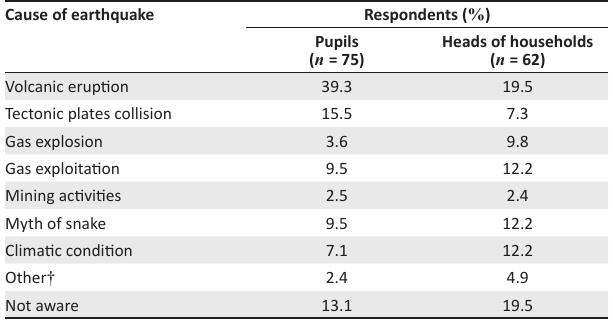
FIGURE 2: Level of awareness of earthquake disaster among pupils. TABLE 1: Responses on causes of earthquake from pupils and heads of